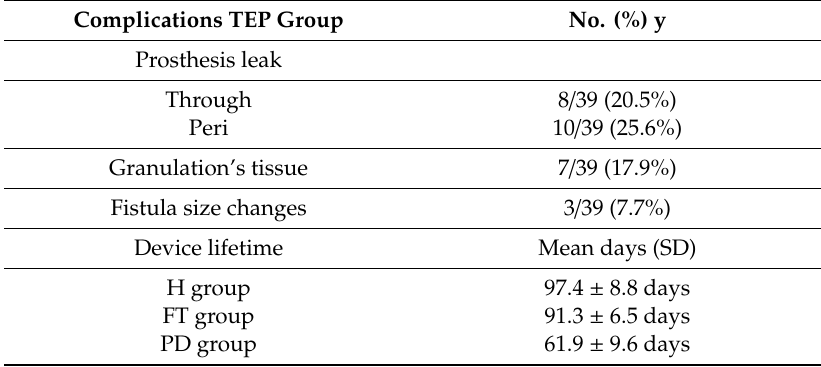
Table 2. Percentage of complications per